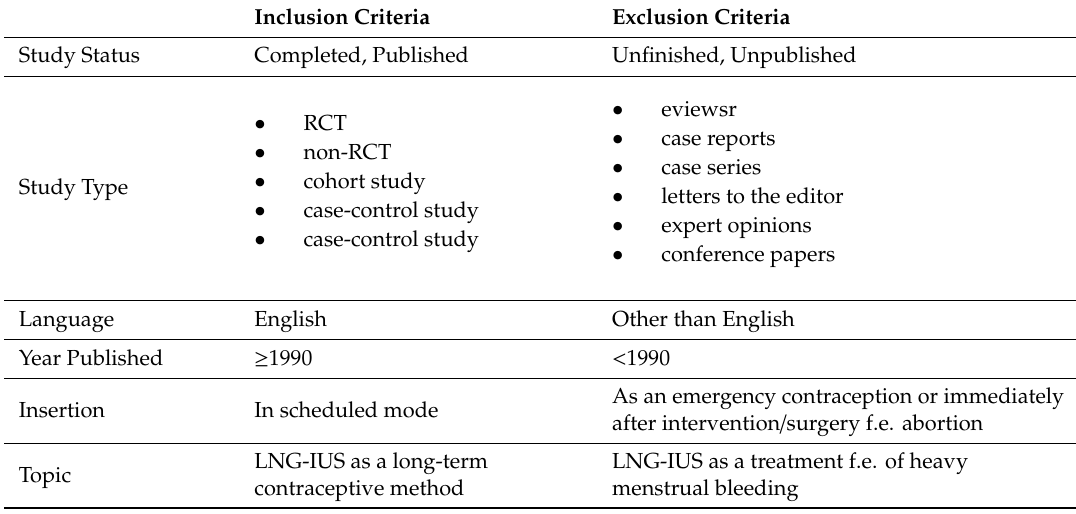
Table 1. The inclusion and exclusion